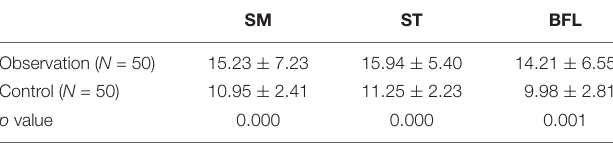
TABLE 3 | Shear modulus (kPa) of the three hamstring in two groups.